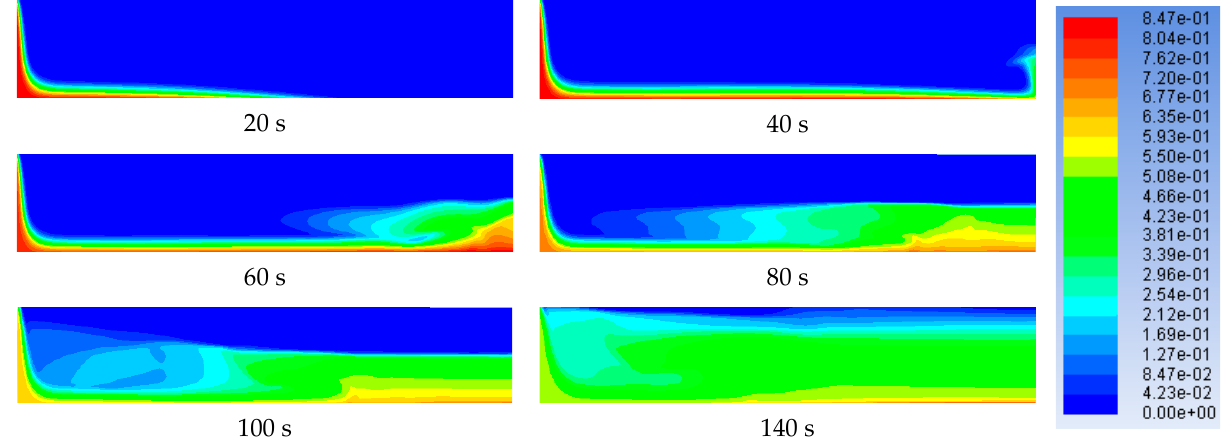
Figure 4. Gravel settlement diagrams at different flow moments.